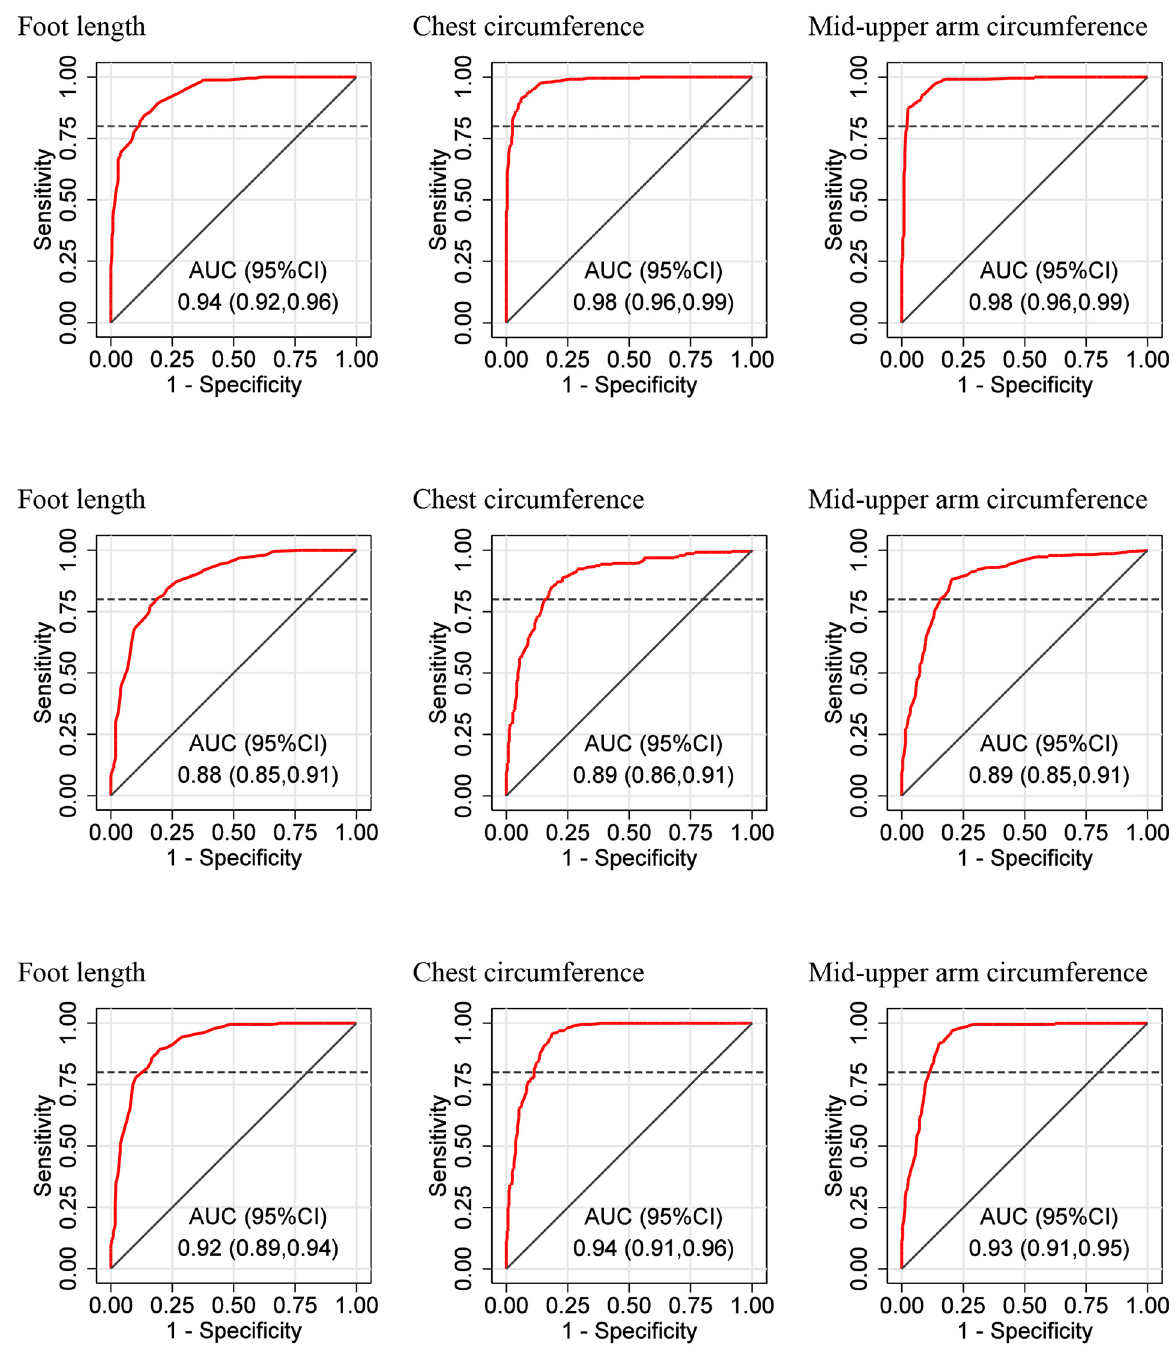
Fig 2. Receiver operating characteristic (ROC) curves for anthropometric measures as diagnostic tools for predicting each outcome, and areas under each curve (AUC). Top row : ROC curves for anthropometric measures as predictors of low birth weight ( < 2500g). Middle row : ROC curves for anthropometric measures as predictors of prematurity ( < 37 weeks according to the New Ballard Score). Bottom row : ROC curves for anthropometric measures as predictors of low birth weight and prematurity. The solid diagonal line represents a theoretical ROC curve that is no better than random as a predictor of the outcome; the dashed horizontal line represents the required threshold sensitivity of 0.8.